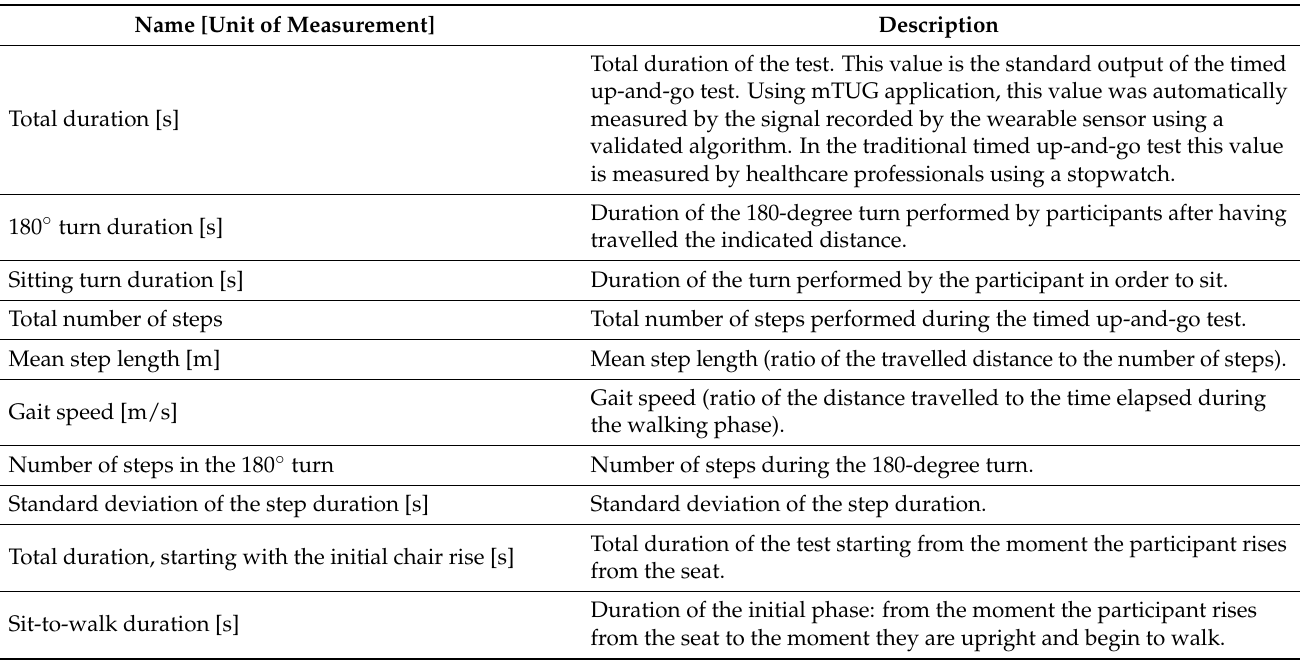
Table 2. Description of the spatiotemporal parameters of the timed up-and-go test analysed during pre- and post-mechanical peripheral